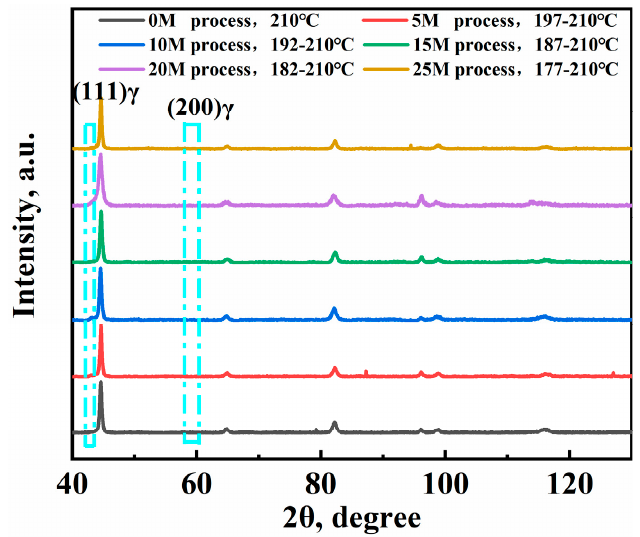
Figure 10. XRD patterns on worn surface of different specimens.